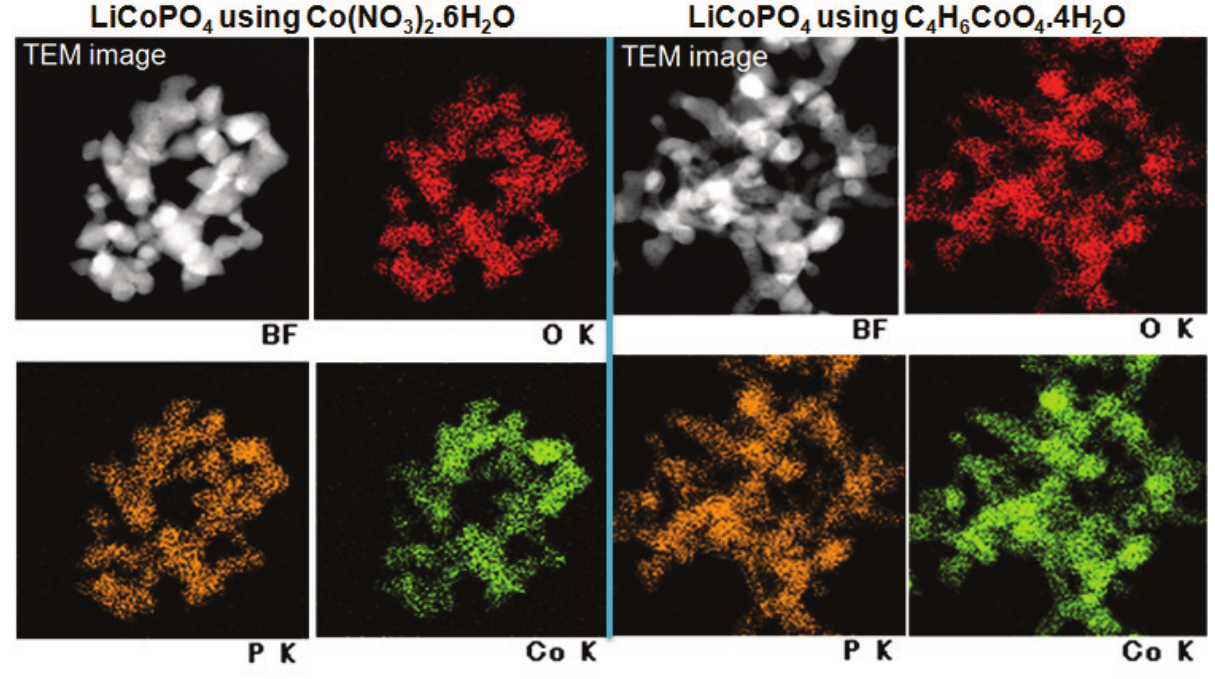
nanoparticles synthesized using Co(NO 4